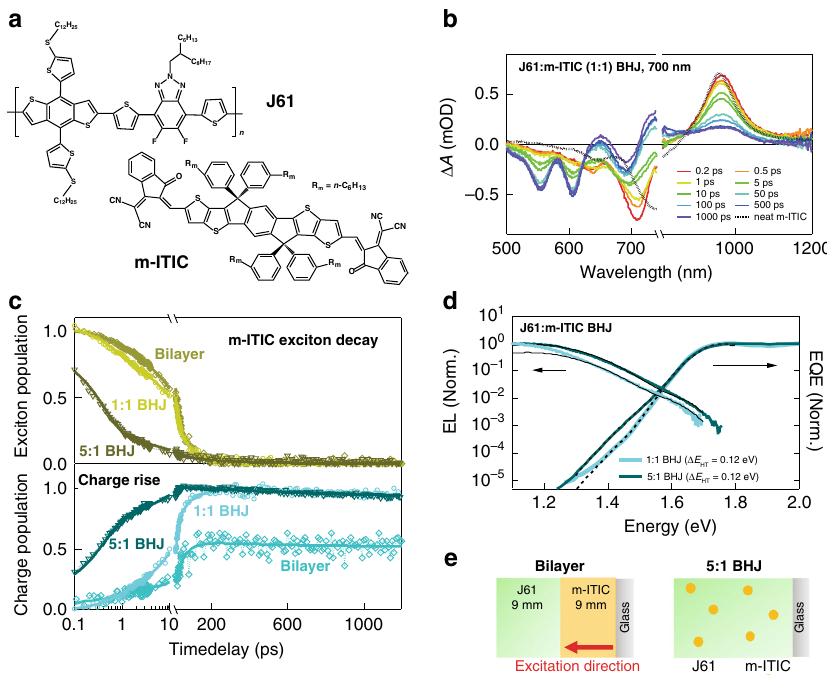
Fig. 1 HT in J61:m-ITIC heterojunctions with different sample con fi gurations. a Chemical structure of m-ITIC and J61. b TA spectra at selected time delays (see legend) recorded for the J61:m-ITIC (1:1) BHJ following excitation at 700 nm. c m-ITIC exciton decay (top) and charge rise (bottom) dynamics for J61:m-ITIC samples under different morphological scenarios, upon selective m-ITIC excitation at 700 – 730 nm, obtained from the analysis of the TA data. The y -axis is expressed as a fraction of the total absorbed photon density. Symbols are the experimental data and solid lines are exponential fi ts obtained globally for the exciton decay and charge rise. d sEQE and EL spectra for the J61:m-ITIC BHJ blends with 1:1 and 5:1 mass ratio. The solid and dashed black lines are fi ts to the EL and sEQE spectra with bi-Gaussian functions, respectively, yielding the S 1 and CT energies as global parameters. e Schematic illustration of the morphology in the J61:m-ITIC bilayer and dilute (5:1 BHJ) samples.